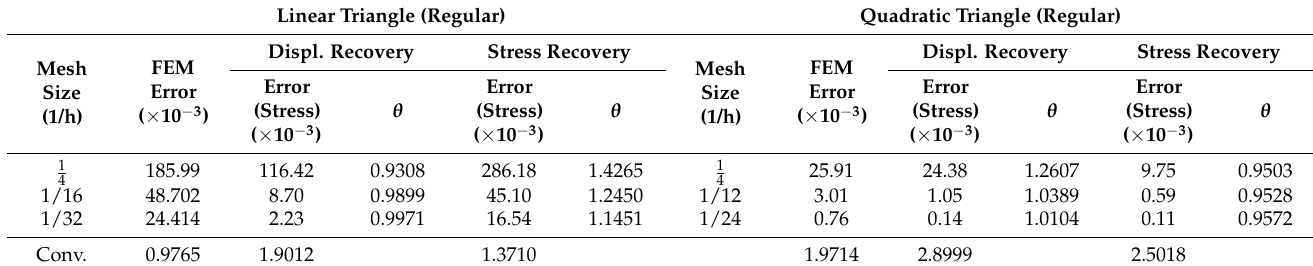
Table 2. Error in stress (L 2 -Norm) and global effectivity ( θ ) in compressible elastic square plate example considering displacement and stress recovery